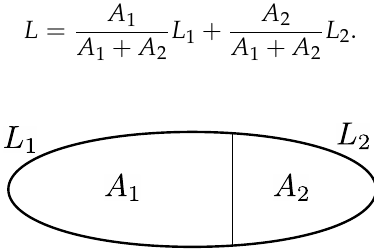
Figure 1. Addition of average area